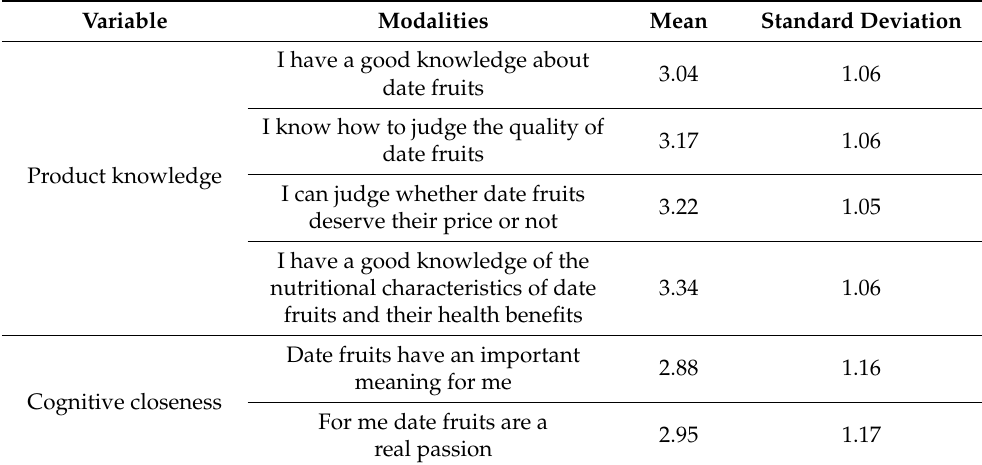
Table 3. Psychographic